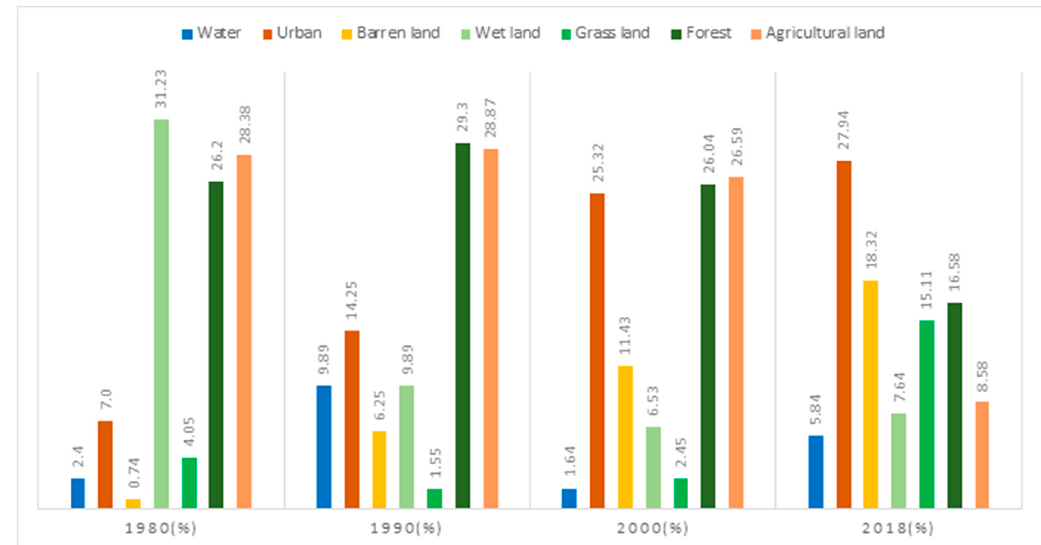
Figure 3. Total land-use class rate from 1980–2018.